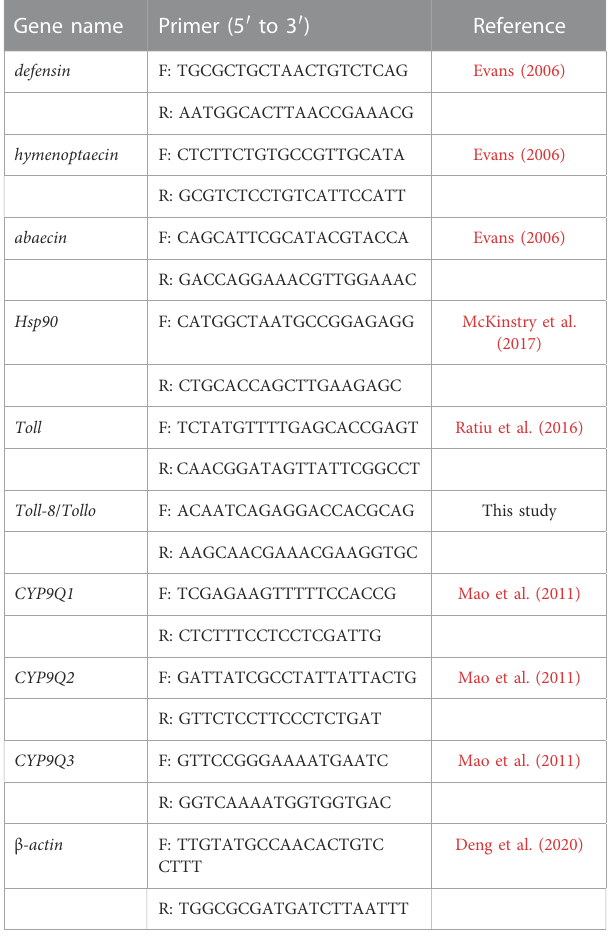
TABLE 1 Sequences of primers for the genes